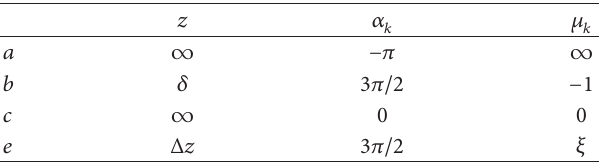
Table 1: Mapping relation between the points in 𝑤 plane and the polygon vertexes in 𝑧